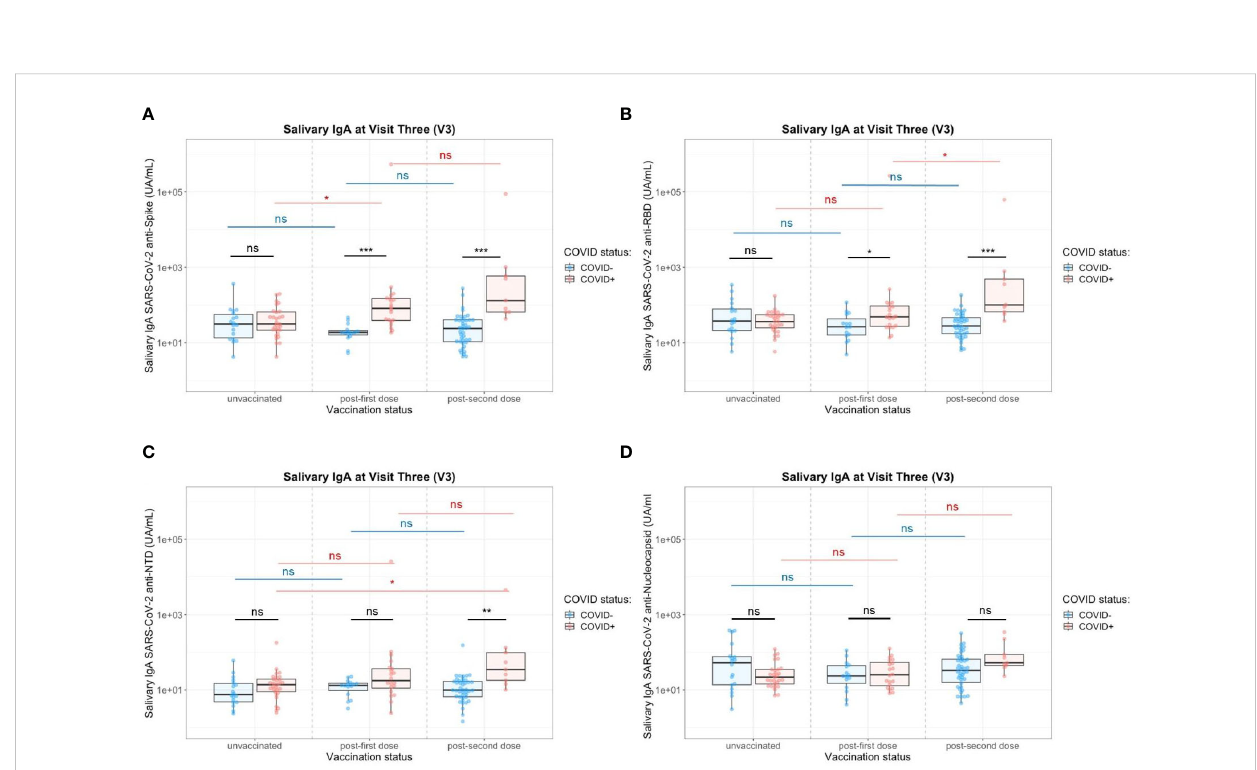
FIGURE 6 Impact of the number of vaccine doses on saliva anti-SARS-CoV-2 IgA titers in the presence (red) or absence (blue) of a previous COVID-19 infection. (A) Salivary IgA titers against the whole Spike. (B) Salivary IgA titers against the Spike/RBD. (C) Salivary IgA titers against the Spike/NTD. (D) Salivary IgA titers against the Nucleocapsid. Two-Way ANOVA tests with Tukey post ’ hoc test: ns, not signi fi cant; * p<0.05; ** p<0.001; ***